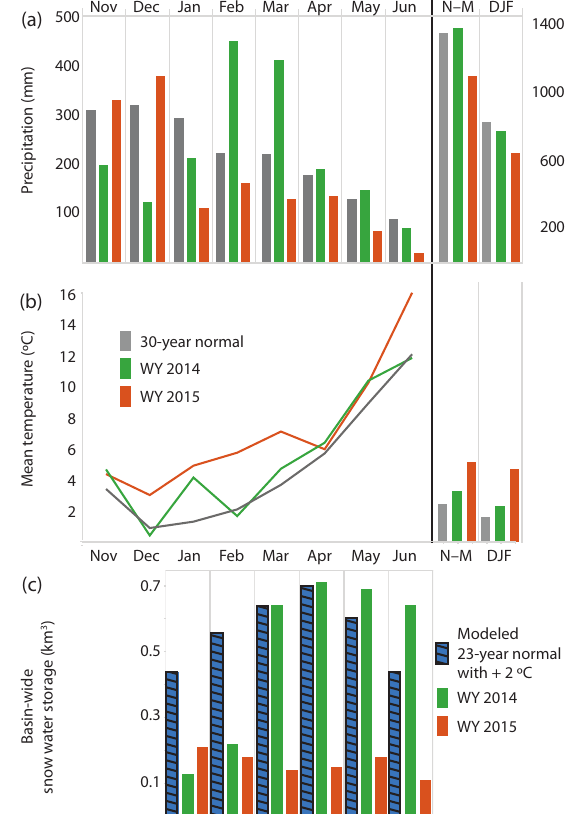
Figure 2. The total precipitation (a) and mean temperatures (b) for the McKenzie River basin for water years 2014 and 2015, as compared to the 30-year normal (from the PRISM data sets). The lower figure (c) represents basin-wide snow water storage for the McKenzie River basin for water years 2014 and 2015 and the nor- mals ( + 2 ◦ C) calculated from the 23 years used in this study. The calculations for snowpack are 5-day averages centered on the first day of each